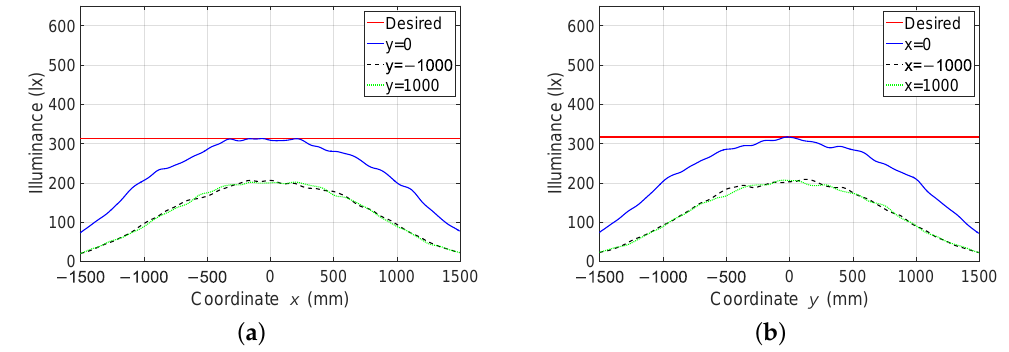
Figure 14. Illuminance distribution curves of the three profiles found using the Quasi-Newton optimization algorithm: ( a ) on the coordinate axis x and ( b ) on the coordinate axis y .